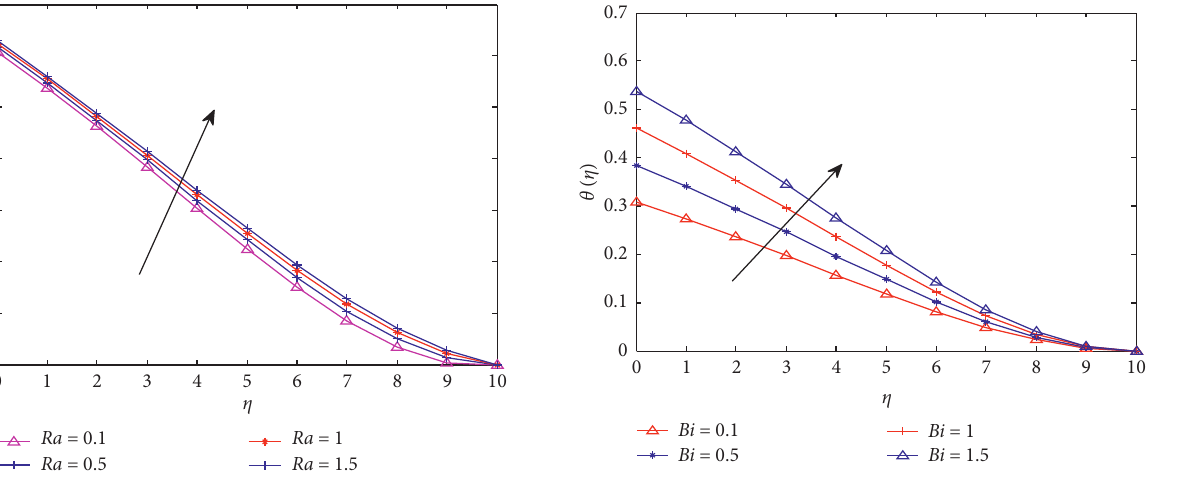
Figure 8: Temperature profiles for various values of the radiation parameter ( Ra ) when λ � 0.1, M � 0.1, Gr � 0.1, Pr � 0.72, and Bi � 0.1.